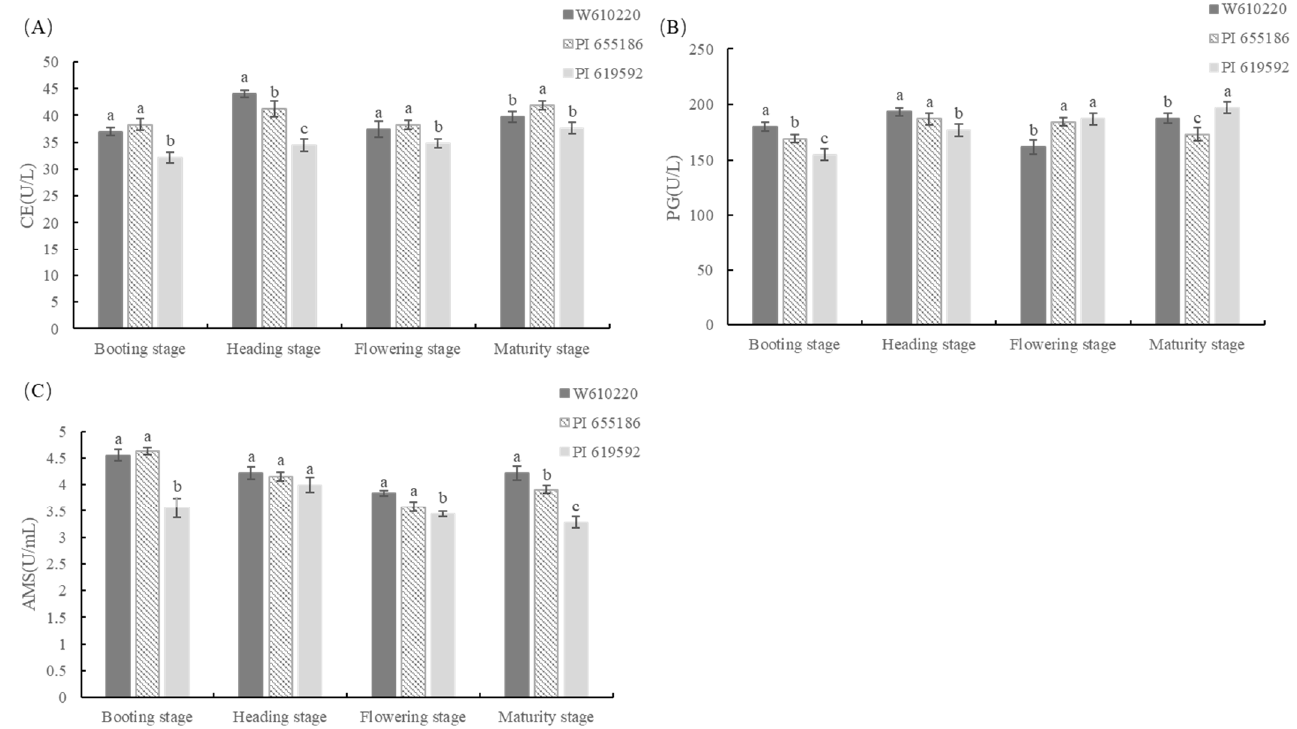
Figure 10. Changes of cell wall hydrolase and amylase contents in awns of three accessions at four growth stages: ( A ) Cellulase, ( B ) Polygalacturonase, ( C ) α -Amylase. Error bars represent mean ± standard deviation. Different normal letters mean significant differences among different treatments at 0.05 level.